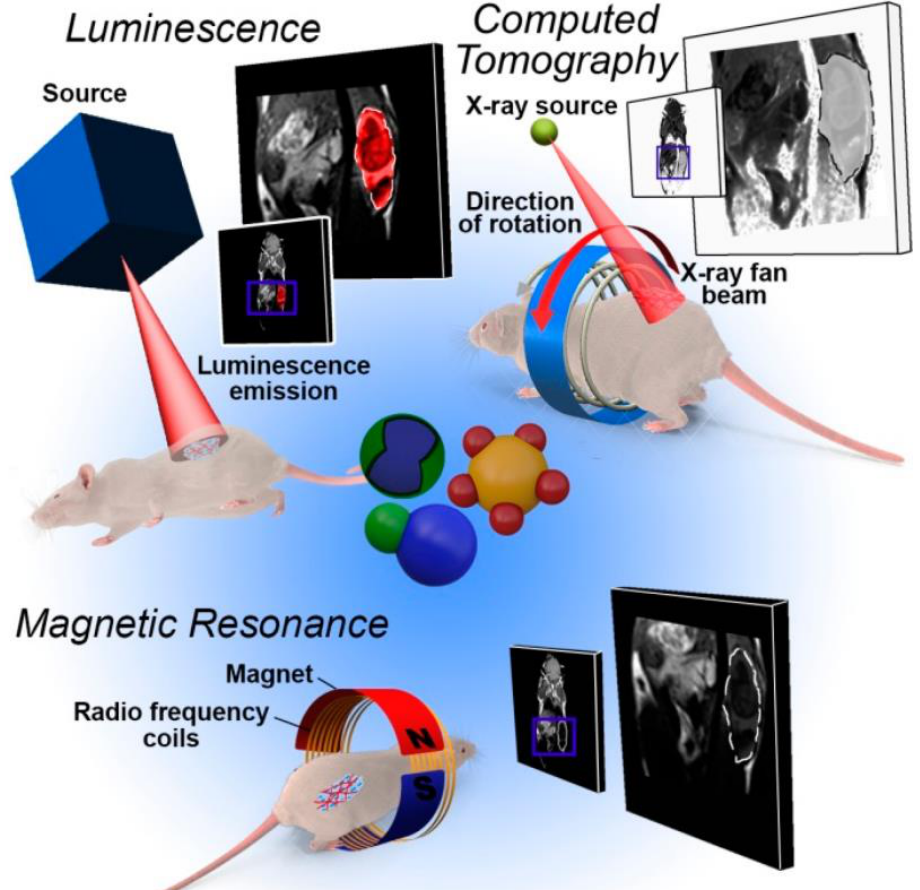
Figure 5. Overview of the imaging techniques most used in heterostructure-based diagnostics. Owing to the multiple domain structure, the patient model can be examined by different imaging methods after the administration and delivery of a single nanostructure [46] .